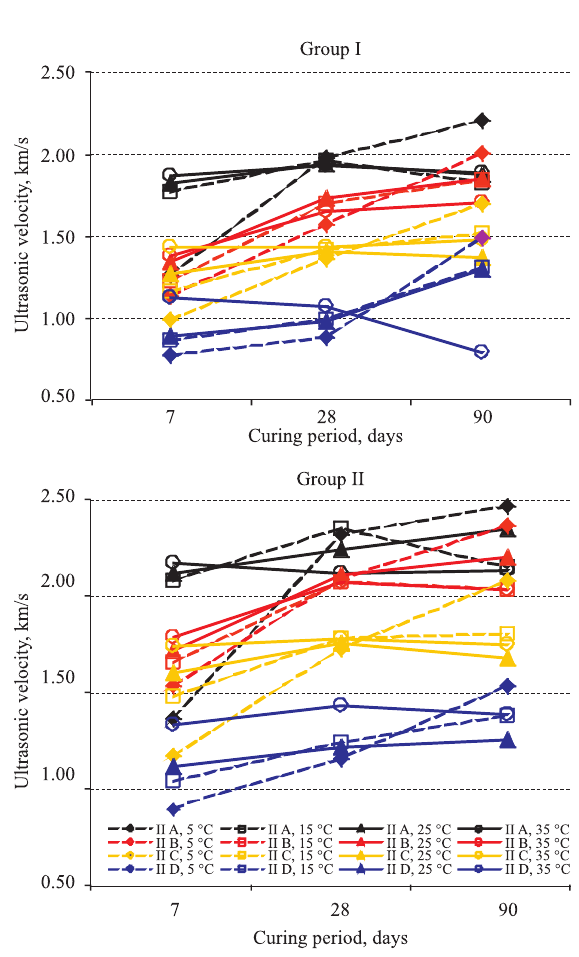
Fig. 2. Influence of the curing period on ultrasonic